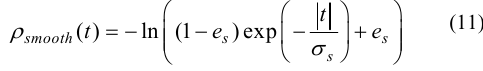
is also a robust function defined similar to Equation (9) with parameters e s and  s .